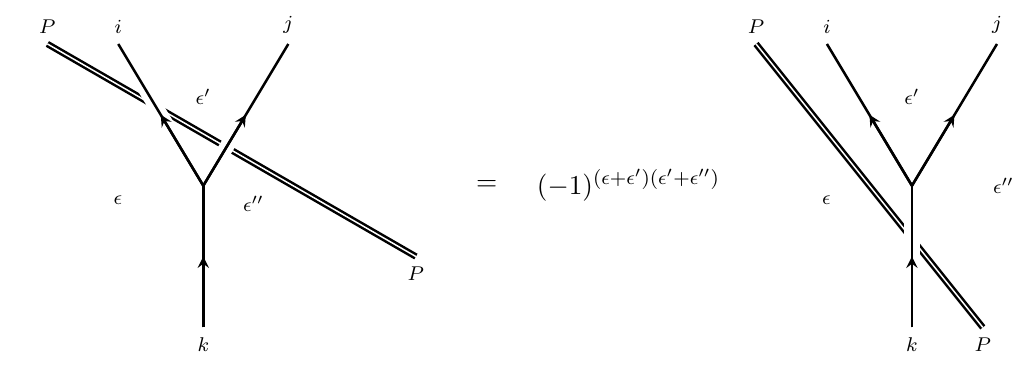
Figure 22 . The equations de(cid:12)ning twisted Drinfeld